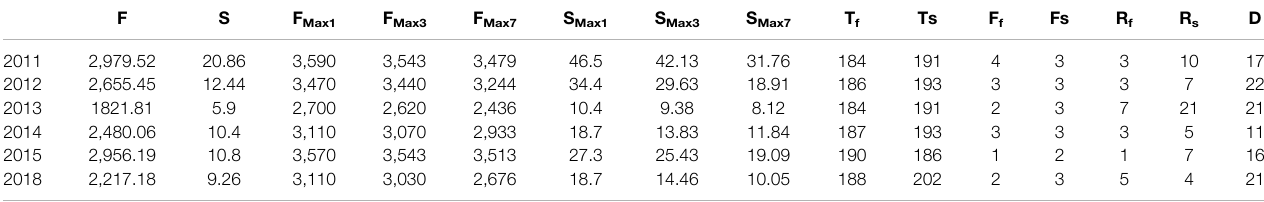
TABLE 4 | Flow-sediment regime indicators during WSRS at the Yellow River Estuary.